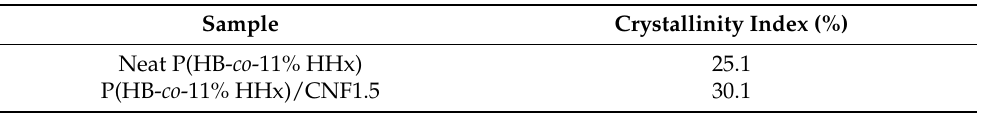
Figure 6. XRD patterns of neat P(HB- co -11% HHx) and optimized P(HB- co -11% HHx)/CNF1.5 bionanocomposites. Table 8. Crystallinity index (CI) of neat P(HB- co -11% HHx) and P(HB- co -11% HHx)/CNF bionanocomposites.